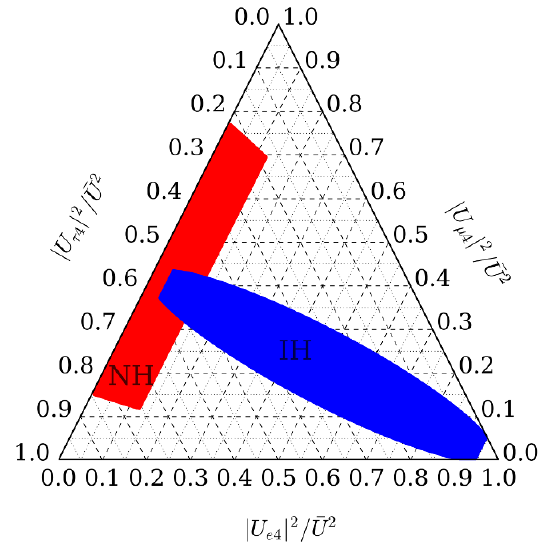
2 = (cid:22) U 2 (in the large mixing U (cid:11)i j j